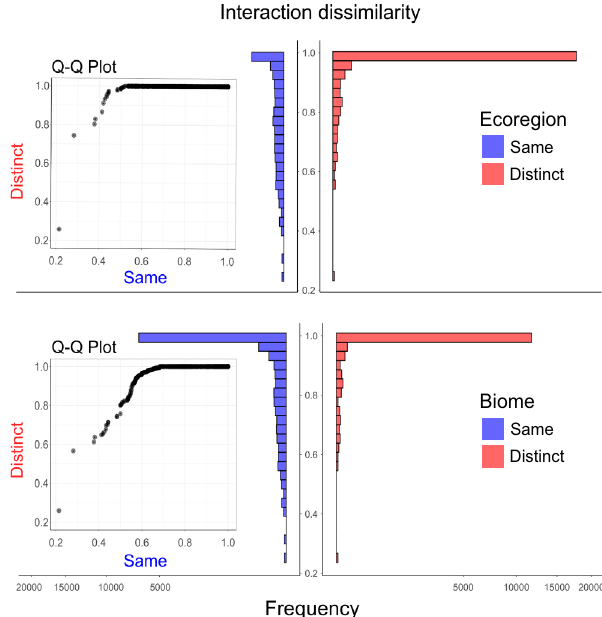
Fig. 3 | The effects of ecological boundaries on interaction dissimilarity ( β WN ). Histograms and inset quantile-quantile ( Q – Q ) plots showing differences in the distributions of interaction dissimilarity values between pairs of networks located within ( “ same ” ) and across ( “ distinct ” ) ecoregions and biomes. The effects of ecoregion and biome boundaries were signi fi cant, even after controlling for the other predictor variables in the model (Table 1). We square root transformed the x-axisscaletoallowabettervisualizationofthedistributionofdatapoints(pairsof networks) with interaction dissimilarity values <1. Source data are provided as a Source Data fi